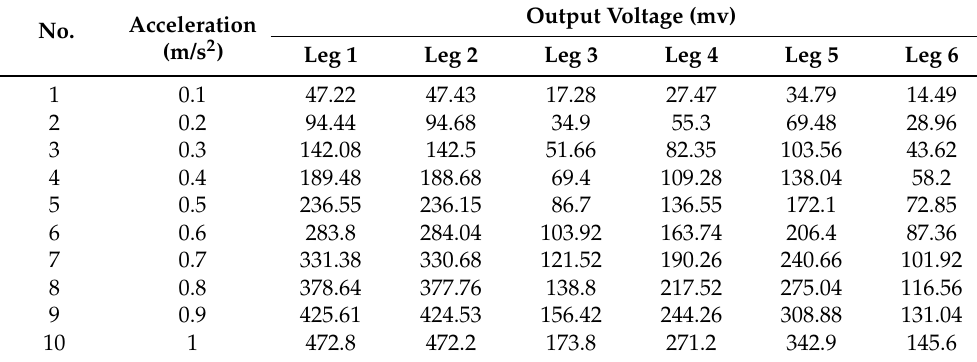
Table 5. Output voltage of each channel on y -axis